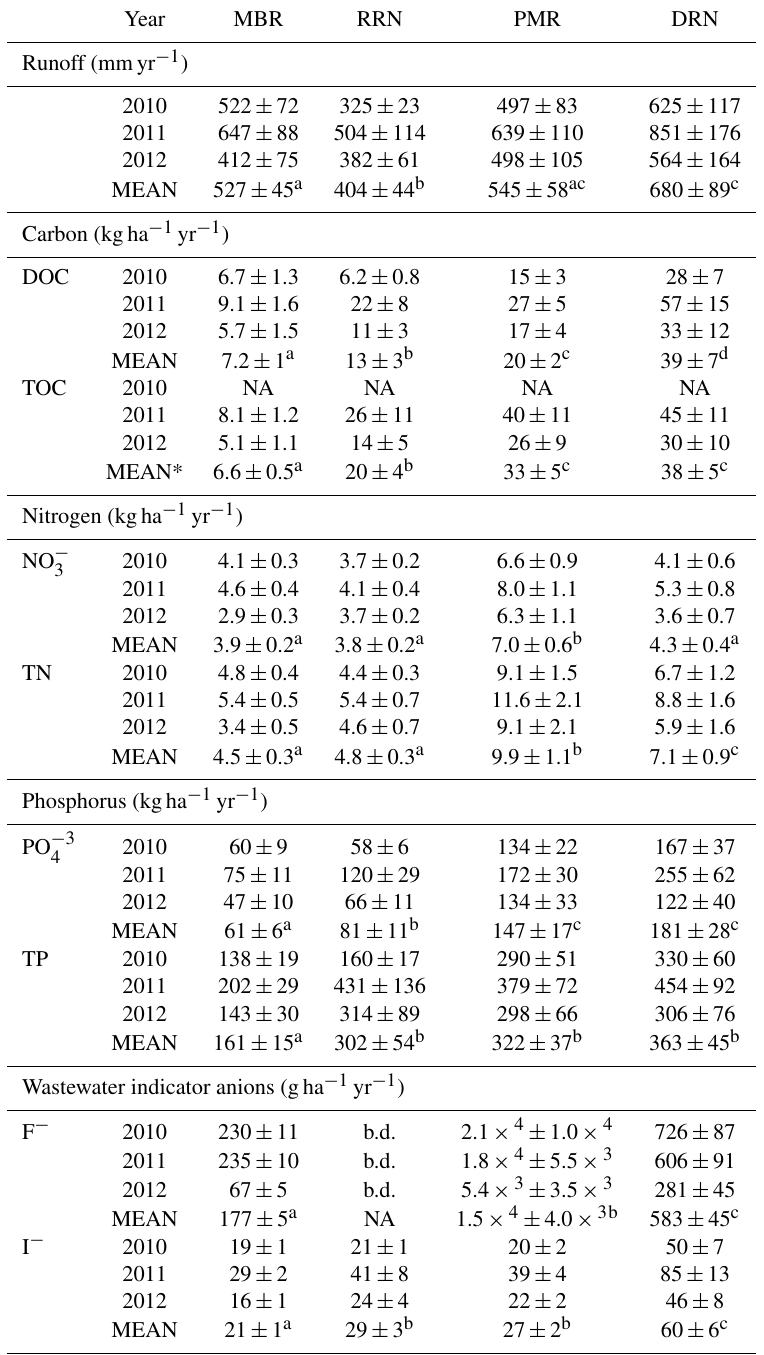
MBR indicates Minebank Run, RRN indicates Red Run, PMR indicates Powder Mill Run, DRN indicates Dead Run. Different letters ( a , b , c , or d ) indicate significant differences, based on 95% CI of exports. DOC indicates dissolved organic C; TOC indicates total organic C; TN indicates total nitrogen; TP indicates total phosphorus; b.d. indicates values below detection. * Note that this range is from 2011–2012, unlike the